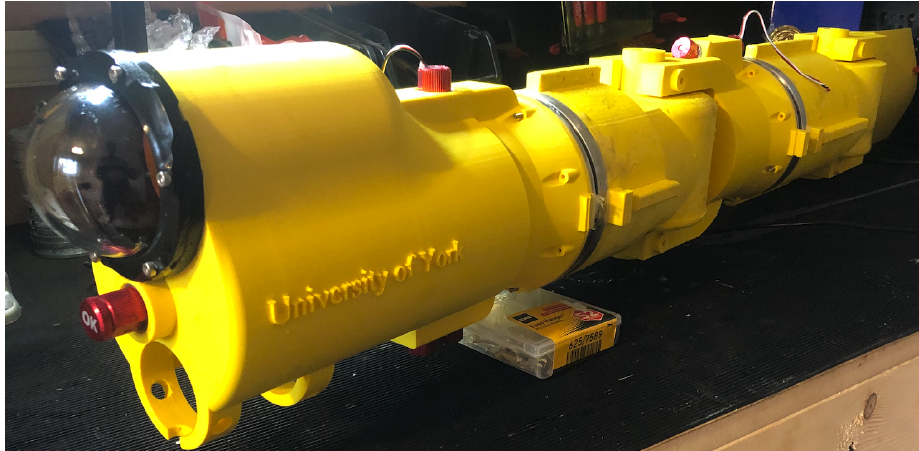
Figure 16. RoboFish prototype with a Head, one Segment and Tail: 3D printed in ASA and us- ing